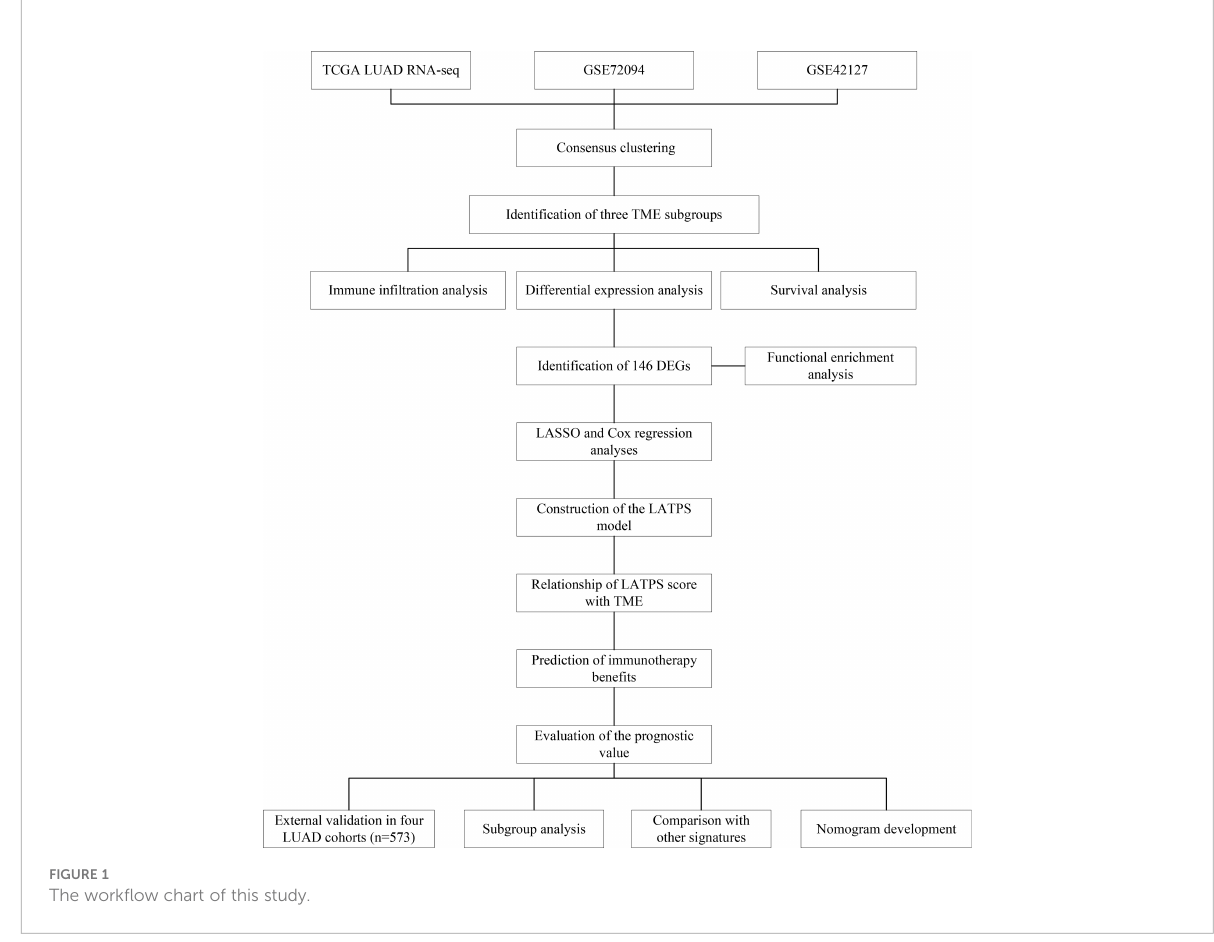
FIGURE 1 The work fl ow chart of this study.